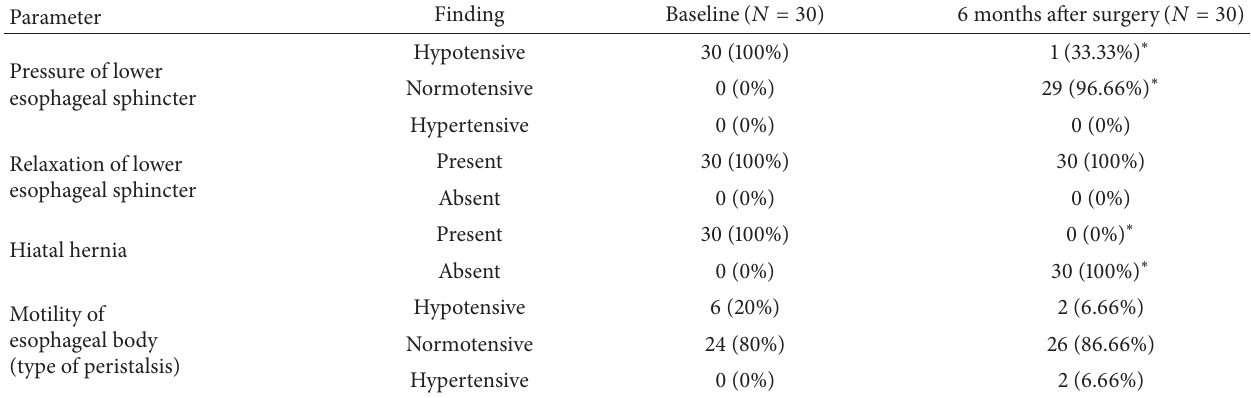
Table 3: Comparison of changes in manometry findings in operated cases.